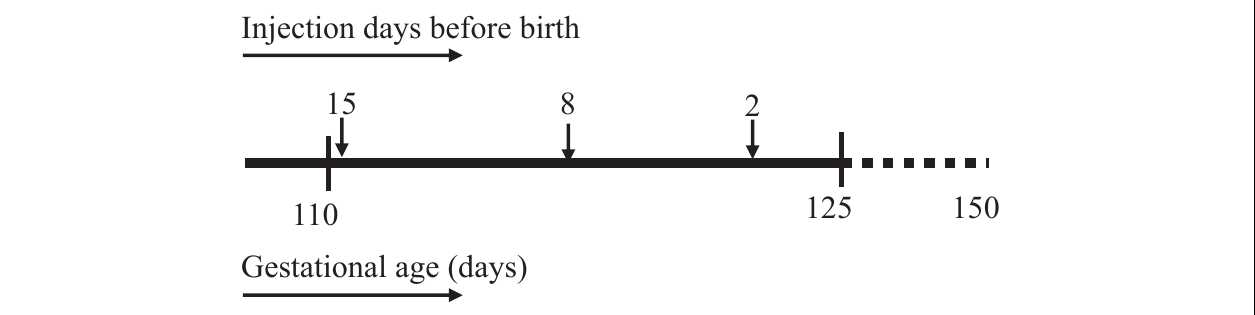
FIGURE 1 | Experimental design. Timeline at the (top) represents intra amniotic (IA) lipopolysaccharide injection at 15, 8, and 2 days before sacrifice. Timeline at the (bottom) represents gestational age in days with the first IA injection at 110 days, sacrifice at 125 days, and illustrating term date at 150 days